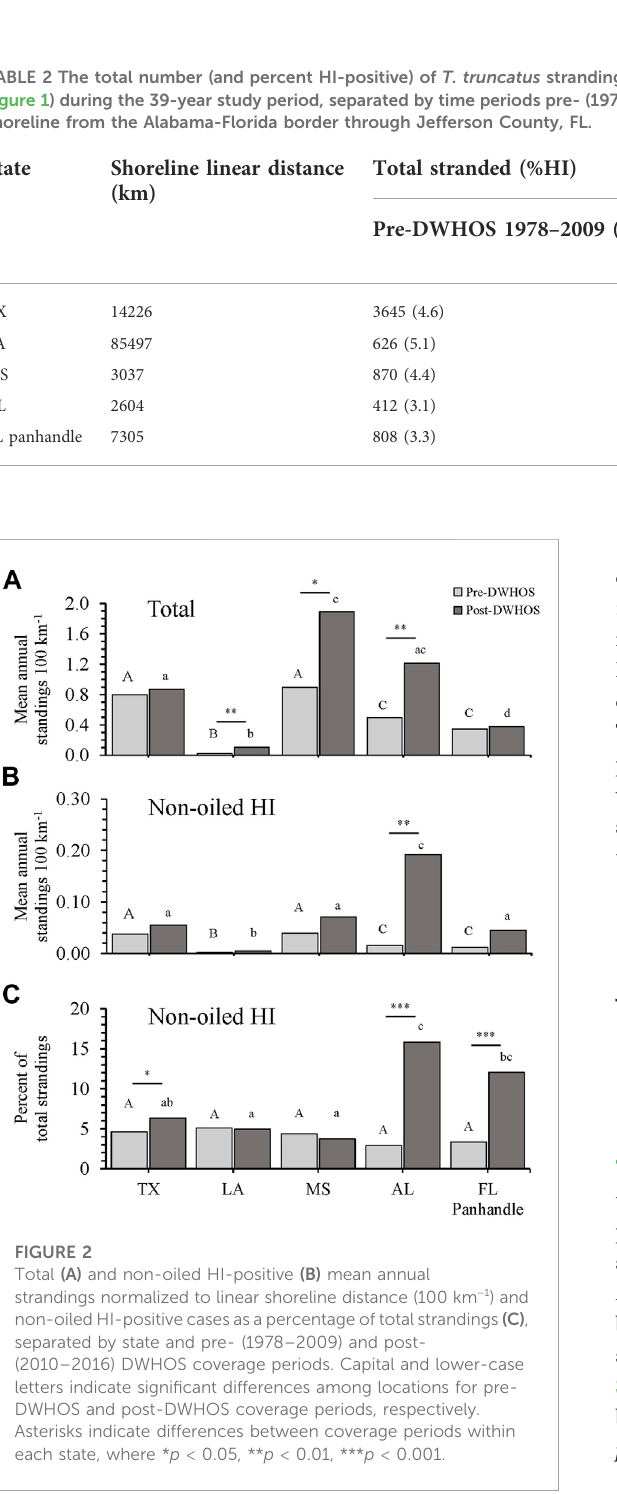
for each respective category. We then used a chi-square test